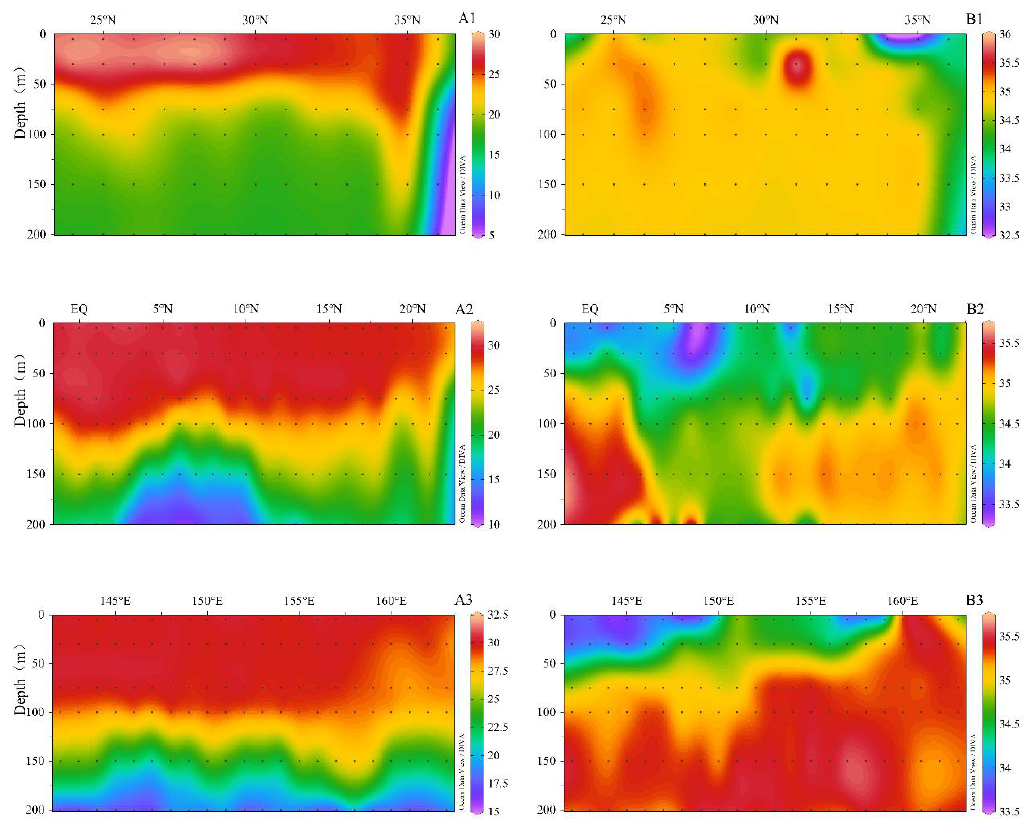
Figure 3. The transection distribution of temperature (°C) and salinity. ( A1 – A3 ) represents the temperature of S1, S2, and S3 and ( B1 – B3 ) represents the salinity of S1, S2, and S3.